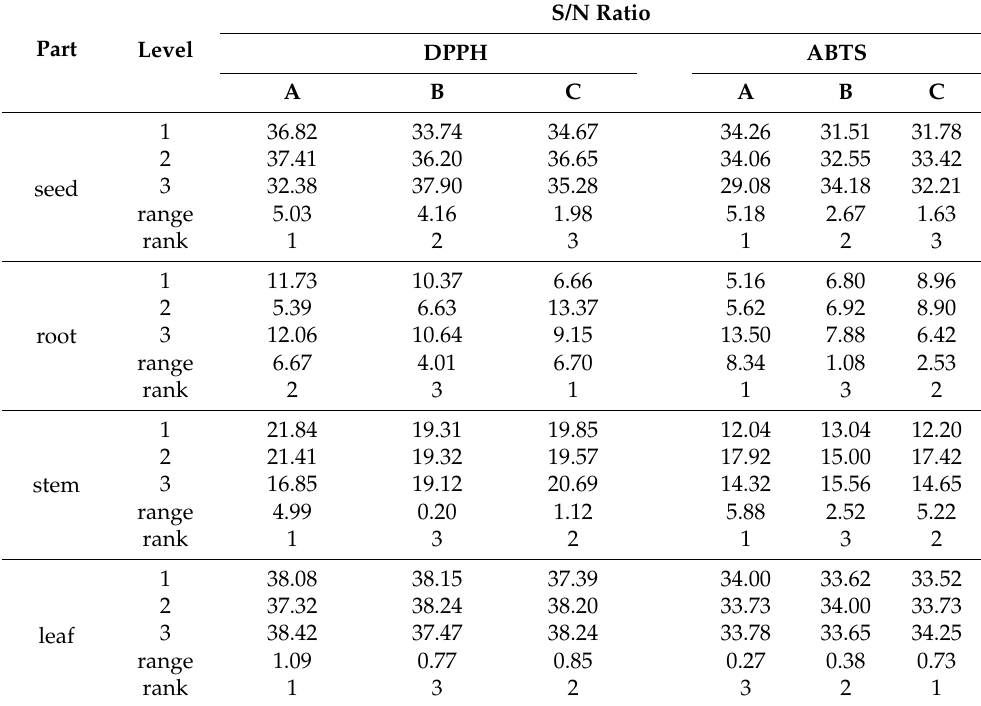
Table 3. The S/N ratio of each part of Chenopodium formosanum .